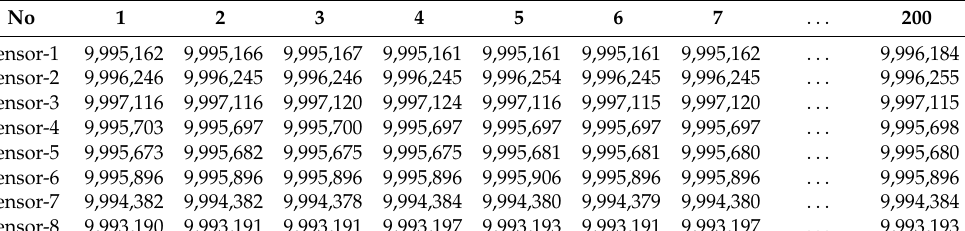
Table 3. Group of raw data of the Moutai sample’s characteristic information.